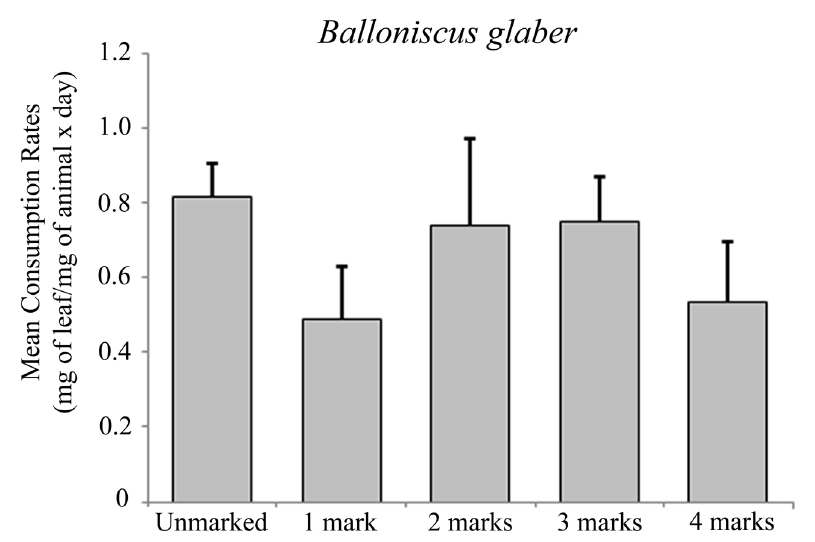
Figure 8. Mean relative consumption of Balloniscus glaber fed with three leaf disks of M. stipitatum during seven days of experiment. Each treatment corresponding to the number of nail polish external marks on animals’ cuticle (zero – unmarked, one, two, three and four). Vertical bars indicate standard